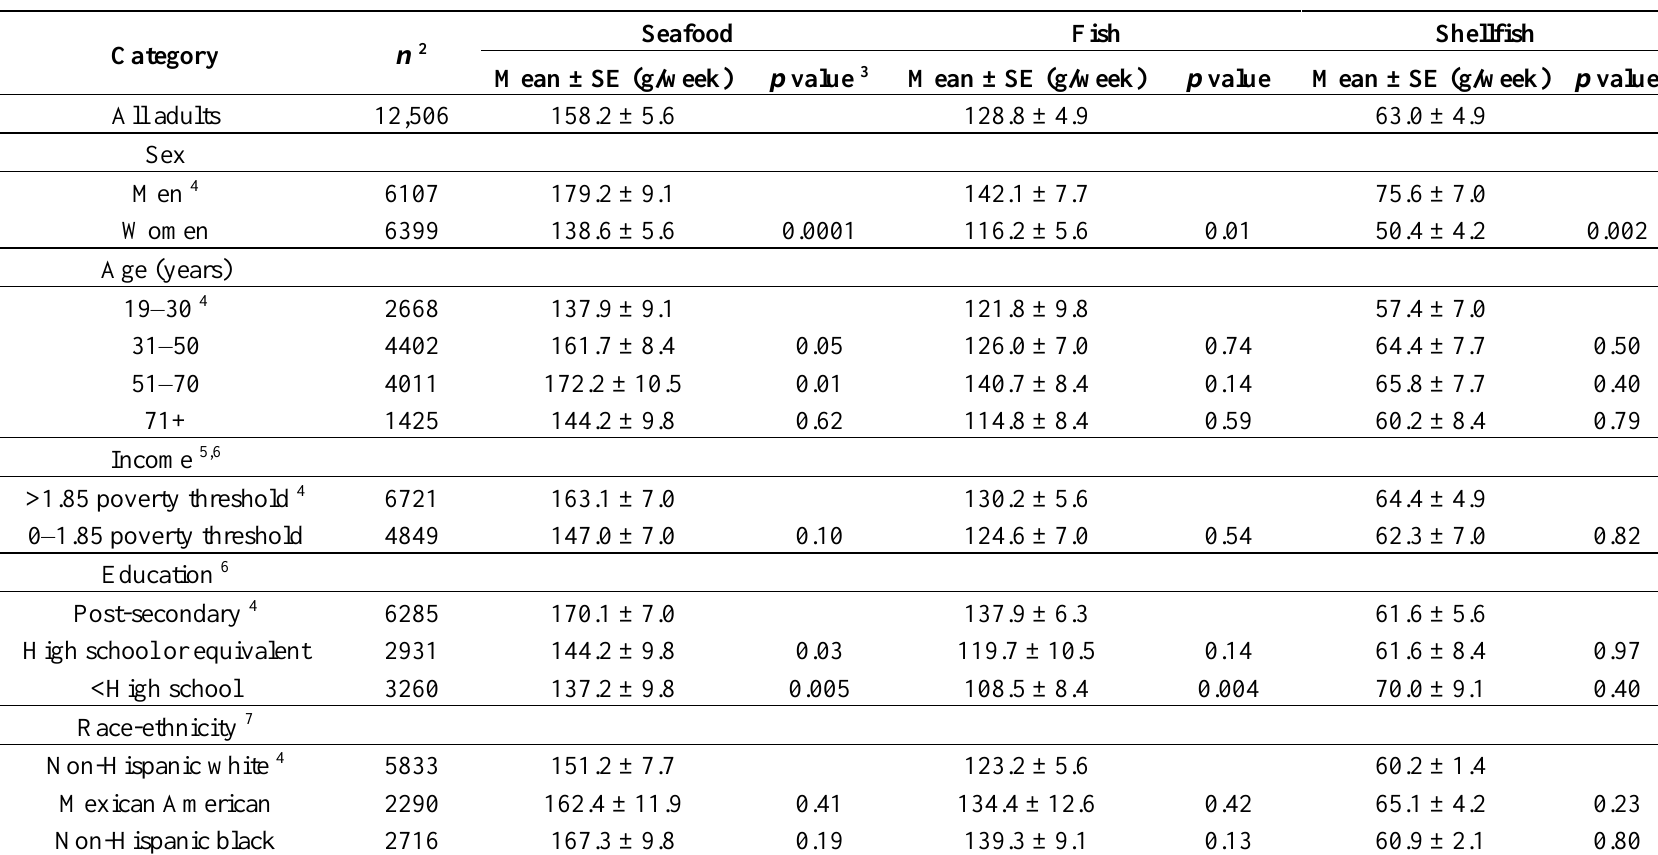
Table 2. Amounts (g/week) of seafood, fish, and shellfish consumed by adults aged ≥ 19 years who report eating seafood in the past 30 days 1